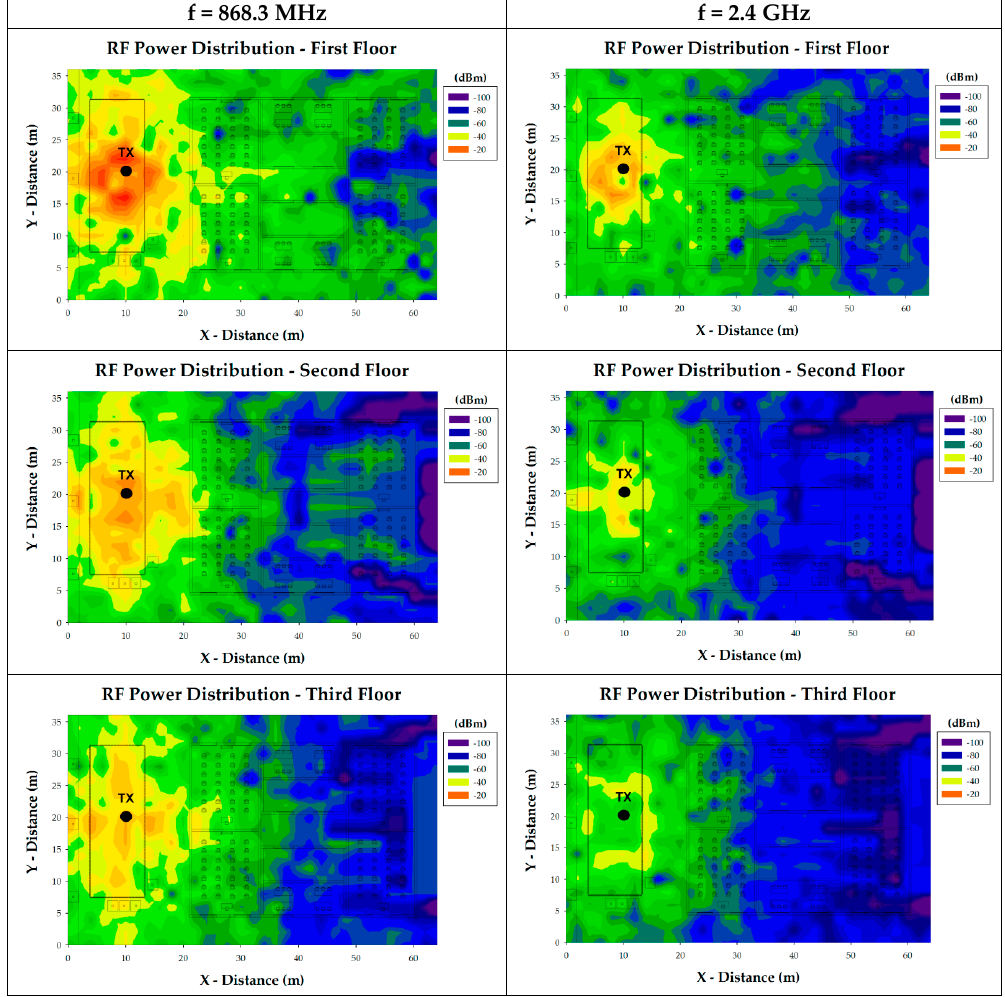
Figure 7. RF power distribution plane comparison between 868.3 MHz and 2.4 GHz frequency for a single wireless sensor placed on the orchard (TX).